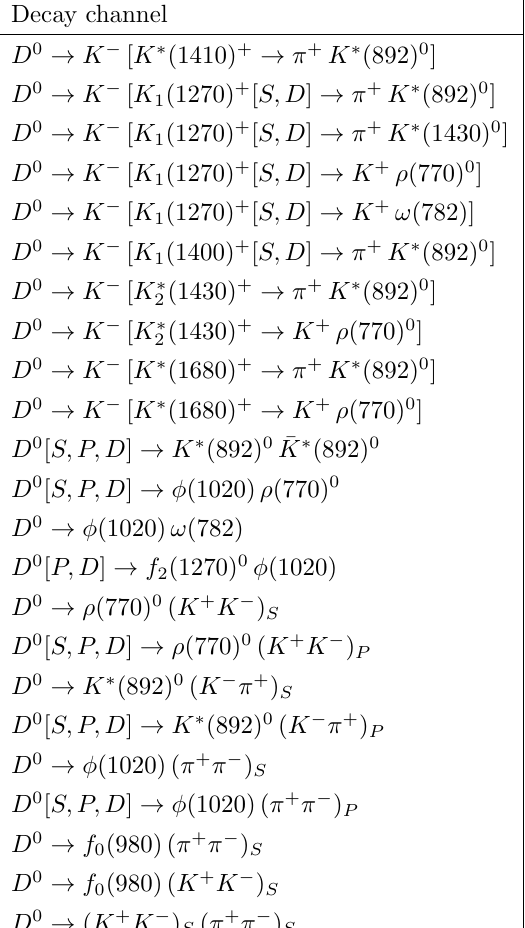
Alternative (cid:12)t models The (cid:12)t fractions and (cid:31) 2 values of the baseline and several alternative models are summa- rized in tables 18{20.